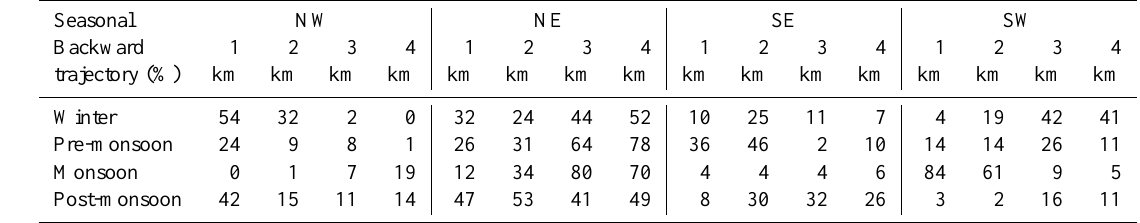
rials, releasing natural fertilizers that help plants grow (Gaur et al., 2014). Figure 8a and b illustrate the daily mean variation of GHGs with respect to soil moisture and soil temperature (top panel represents the seasonal variation of CO 2 w.r.t. soil moisture and soil temperature, while the bottom panel rep- resents the seasonal variation of CH 4 against the same pa- rameters). It is quite interesting to observe that GHGs be- have differently w.r.t. soil moisture during different